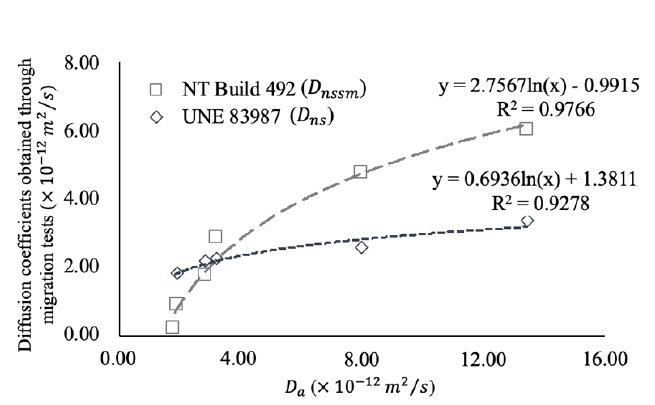
Figure 10. Correlation between the results obtained through the different test methods